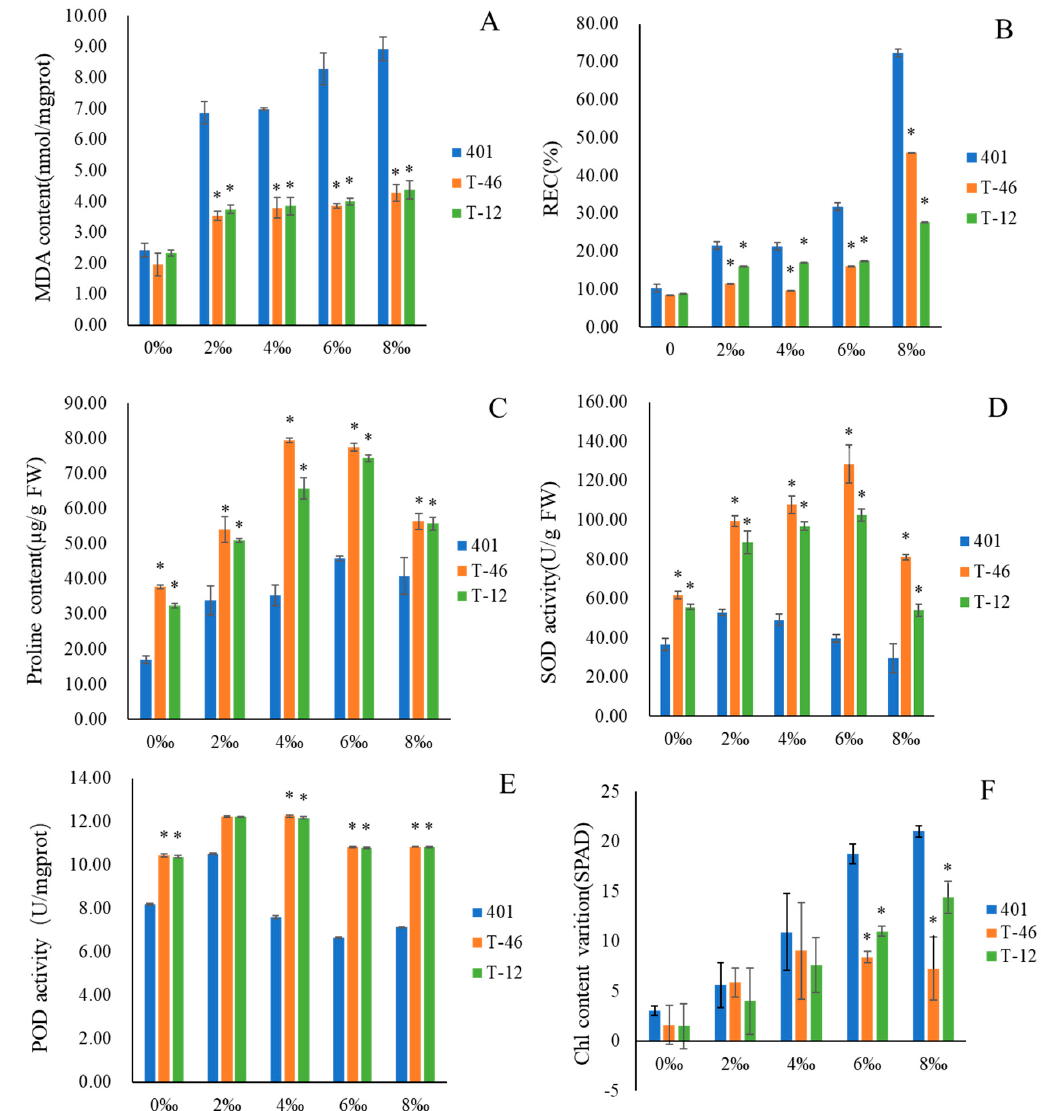
Figure 3. The variations in physiological and biochemical properties after NaCl treatment: Malondialdehyde (MDA) content ( A ), relative electrolyte leakage ( B ), proline content ( C ), SOD activity ( D ), POD activity ( E ), chlorophyll content ( F ). “*” denotes a significant difference ( p < 0.05, α = 0.05) between treatments. Error bars represent the standard deviation.